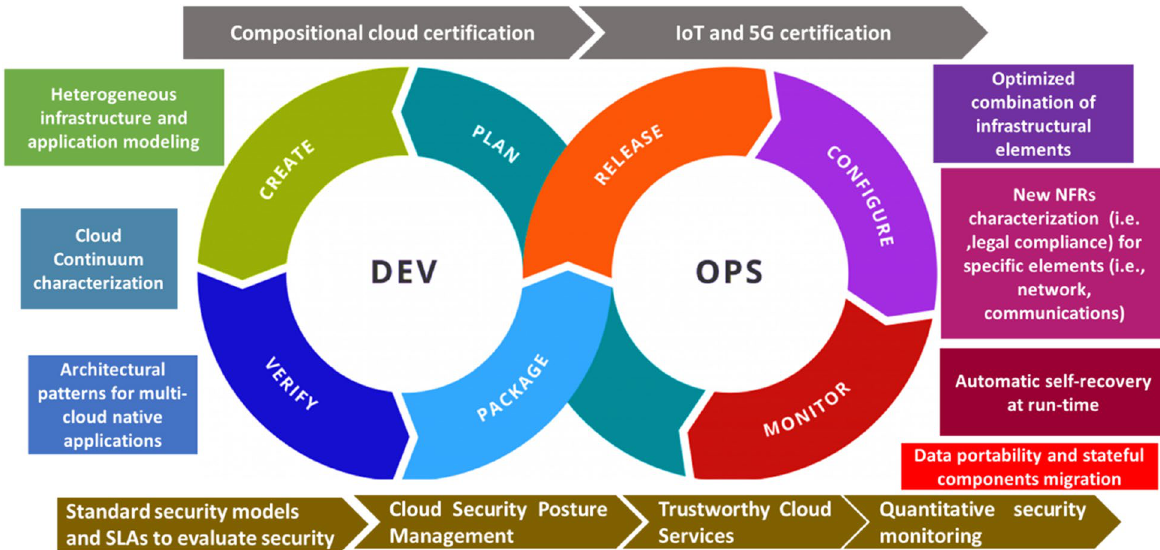
Fig. 15 Overview of the identified research trends in the DevOps lifecycle of multi cloud native